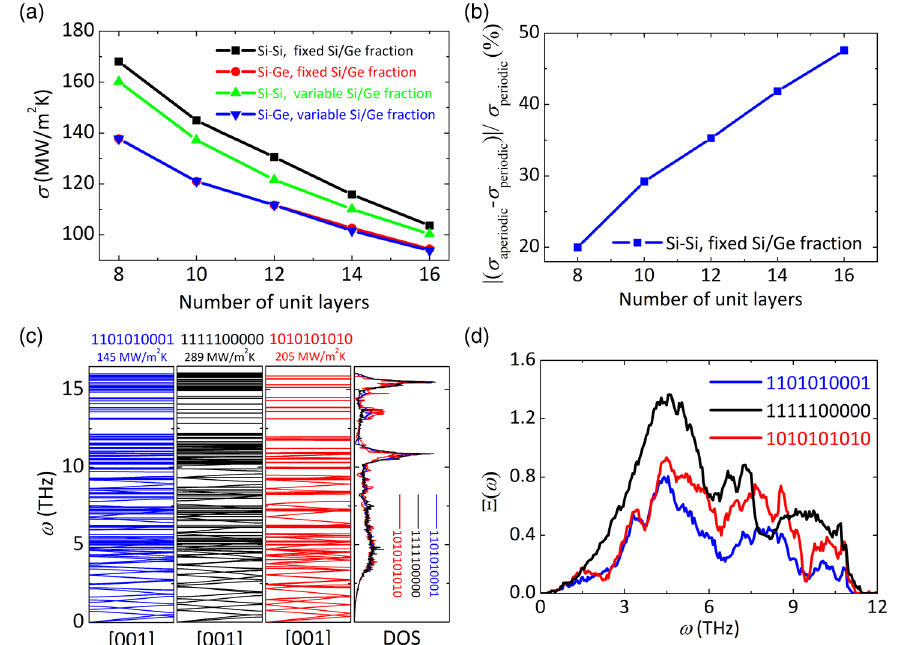
FIG. 4. (a) Comparison of ITC of interfacial structures at Si-Si and Si-Ge interfaces with variable ULs. (b) The reduction ratio jð σ − σ Þj = σ , where σ is the ITC of the optimized aperiodic superlattice, and σ aperiodic periodic periodic aperiodic corresponding periodic superlattice with period thickness optimized for each number of ULs (i.e., total length). The comparison of (c) the phonon dispersion and DOS, and (d) the phonon transmission for three superlattice structures optimal aperiodic superlattice (1101010001), and periodic superlattice with the largest (1111100000) and smallest (1010101010) periodic